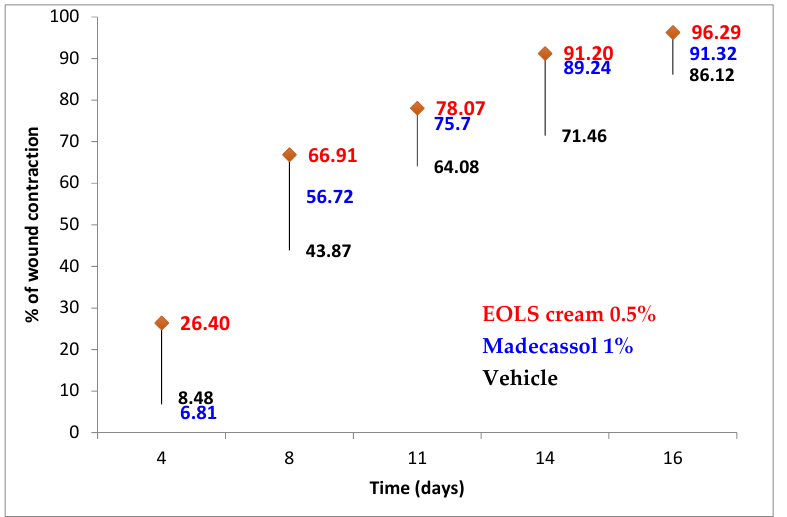
Figure 4. Effect of EOLS cream formulation treatment on rate of wound contraction in rats.